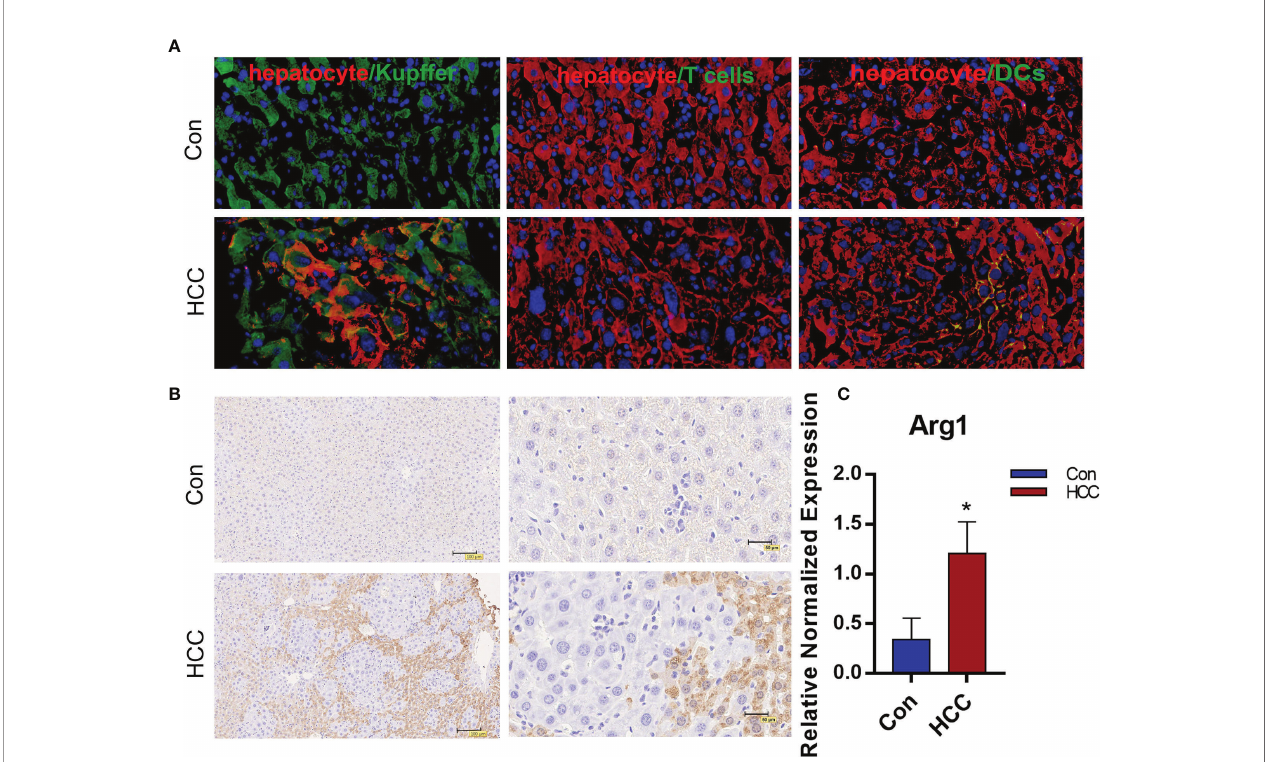
FIGURE 4 | The distribution of immune cells and expression of Arg1 in liver tumors. (A) . Distribution of macrophages, T cells and DCs in tumor tissues. The macrophages labeled with Alexa Fluor594, hepatocytes with FITC and the nuclei counterstained with DAPI in the fi rst panel. T cells and DCs with FITC, hepatocytes with Alexa Fluor594, the nuclei counterstained with DAPI in the second and third panels. (B) Arg1 expression in the mouse liver. (C) Arg1 mRNA levels in Kupffer cells. Mean ± S.D; n=3, Statistical signi fi cance is determined with t test;